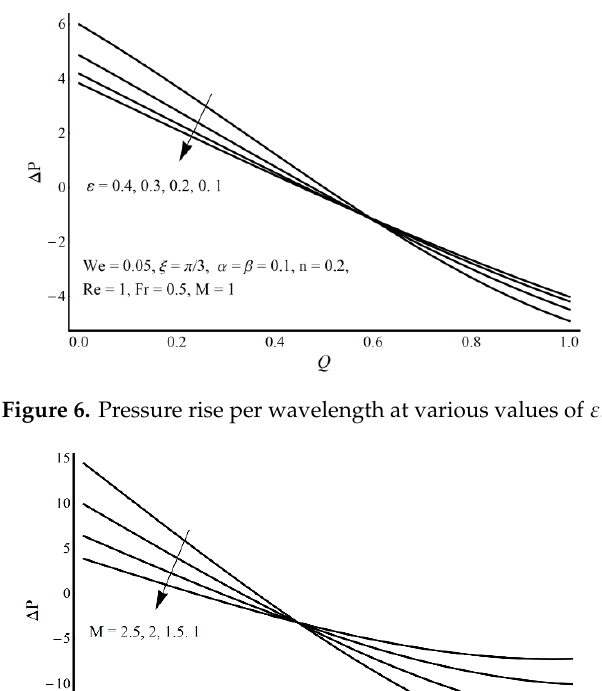
Figure 5. Pressure rise per wavelength at various values of α.